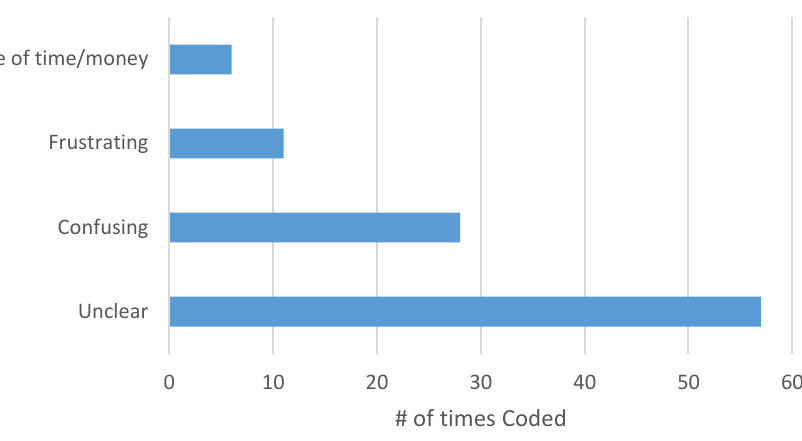
Figure 12. Coded Responses to P&E Signage (Clarity).